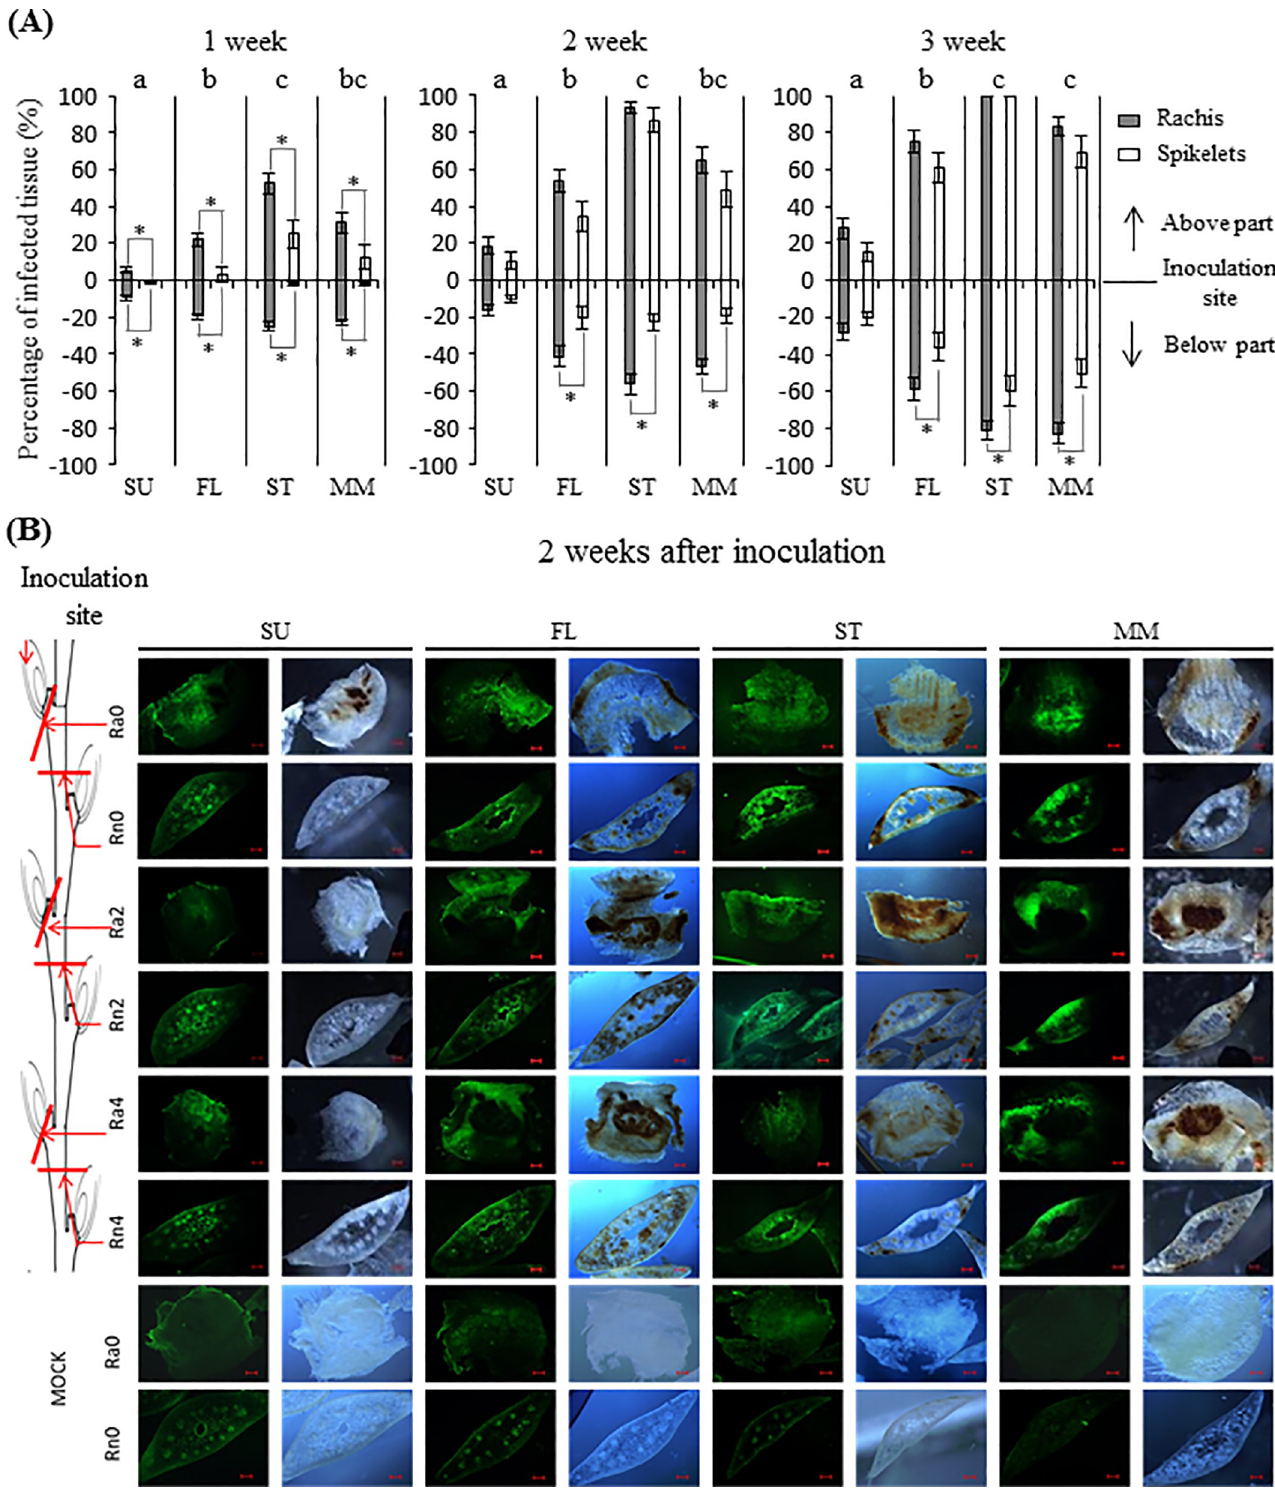
Fig 1. Disease assessment of four wheat varieties. (A) Macroscopic disease symptoms are indicated as the percentage of bleached or brown rachis internodes (grey bar) and spikelets (white bar) above or below the inoculation site over a three-week period. Values represent means ± standard error. For each variety, the Student’s t test was performed between the percentage of infected rachis internodes and spikelets. � indicates P < 0.05. Among the four varieties, a one-way ANOVA of data based on infected rachis internodes was performed at each time point at α = 0.05 to determine significance. Histograms with different letters are